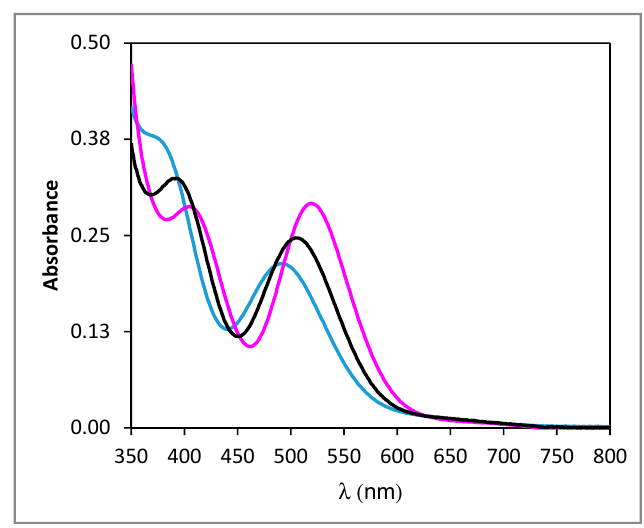
Figure 3. Individual UV-vis spectra of [RhCl 4 ] − (blue line), [RhCl 5 ] 2 − (black line) and [RhCl 6 ] 3 − (pink line) as derived from the MCR analysis of the experimental UV-vis data (see text for assignment).